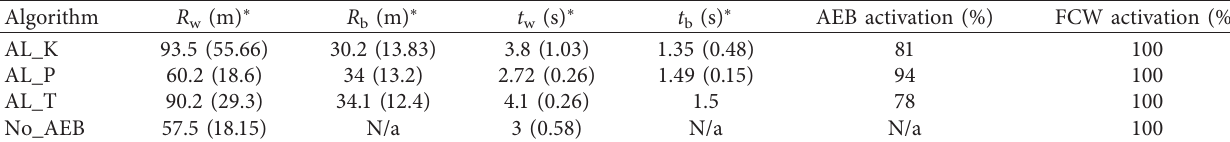
Table 6: The summary of AEB and FCW performance regarding the DTC, TTC, and activation rate for the AEB and FCW algorithms.